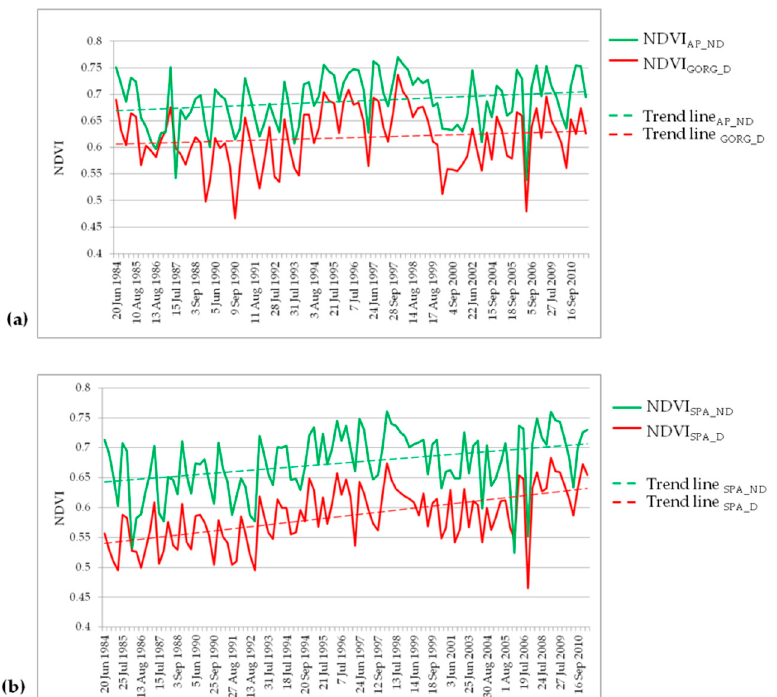
Figure 6. Time series of NDVI spatial average from TM-Landsat-5 images over ( a ) Gorgoglione D (red line) and Accettura-Pietrapertosa ND (green line) forests. ( b ) D (red line) and ND (green line) forests in San Paolo Albanese. Dashed lines are the corresponding trend lines.